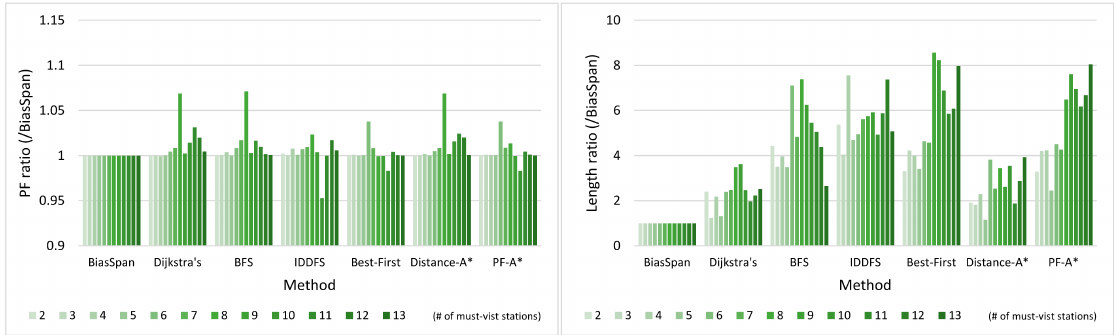
Figure 7. PF ratio ( left ) and length ratio ( right ) for methods under number of must-visit stations in Chicago dataset.